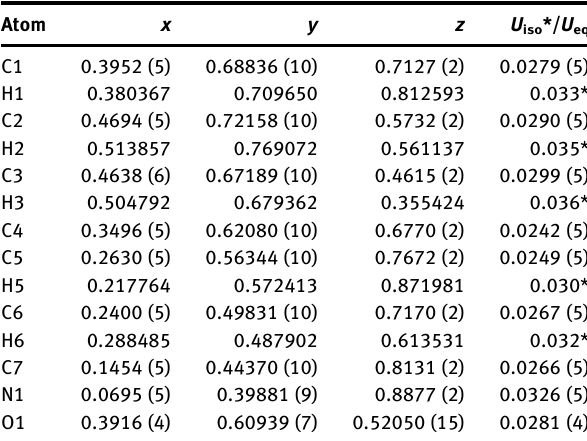
Table  : Fractional atomic coordinates and isotropic or equivalent isotropic displacement parameters (Å 